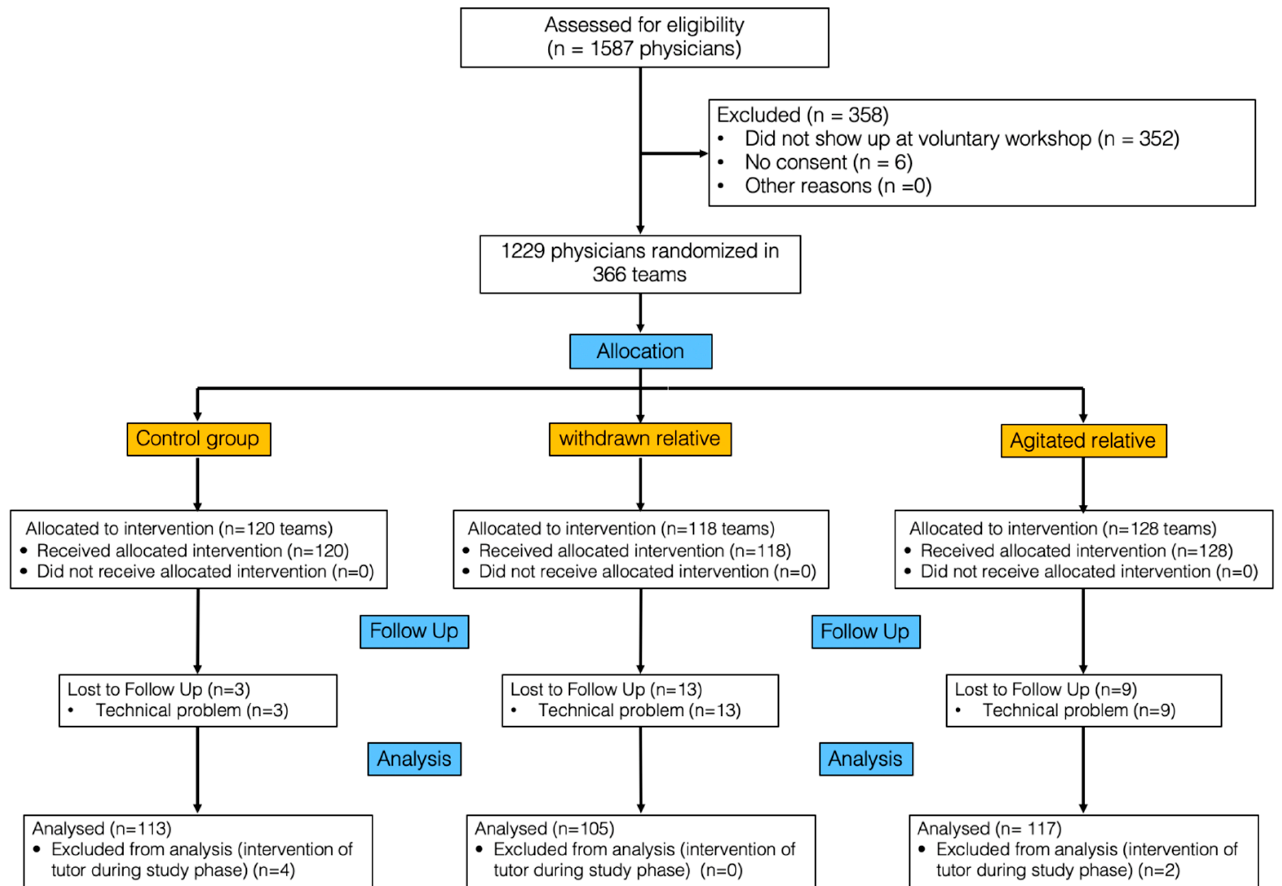
Figure 1. CONSORT flow chart.